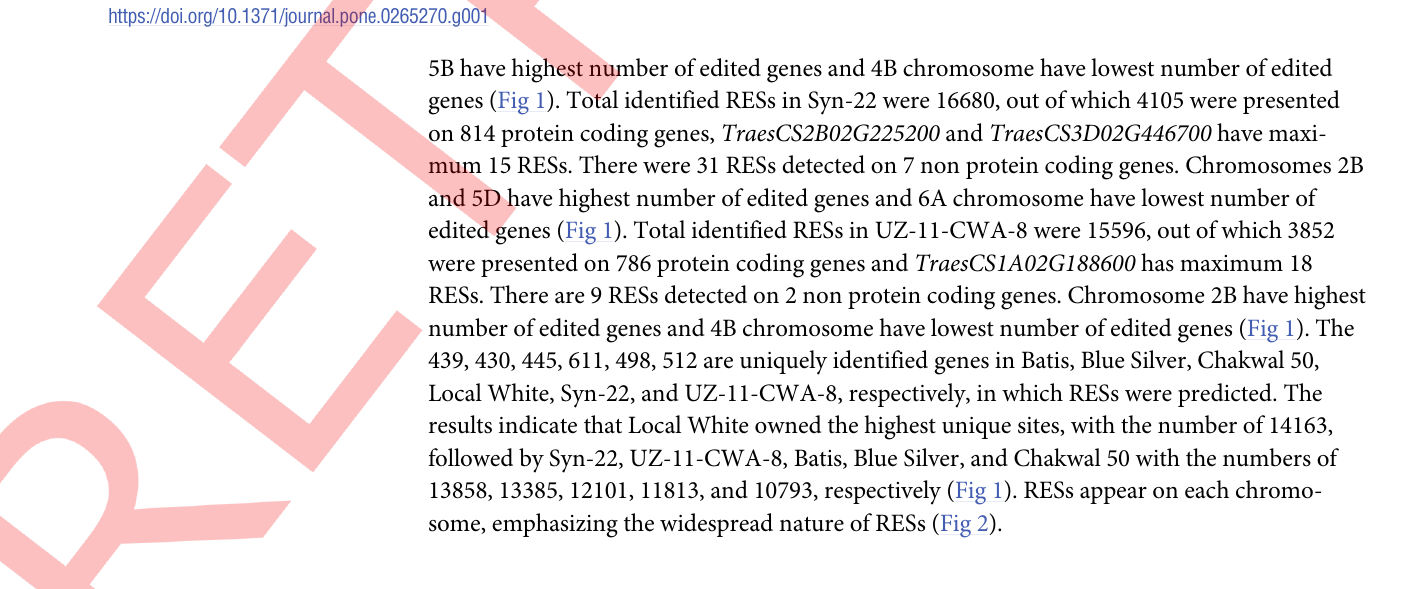
PLOS ONE | https://doi.org/10.1371/journal.pone.0265270 March 11,